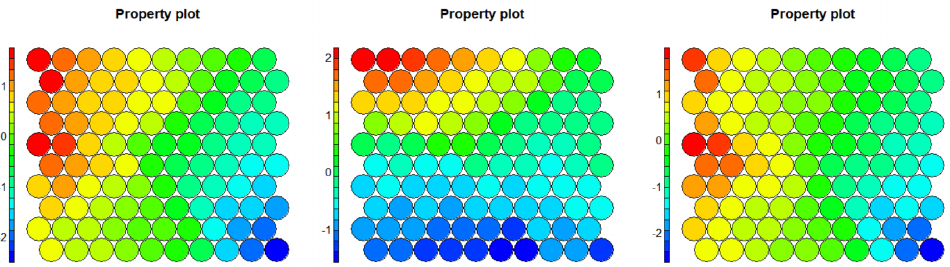
Figure 16. Property plots of Stratum 4.